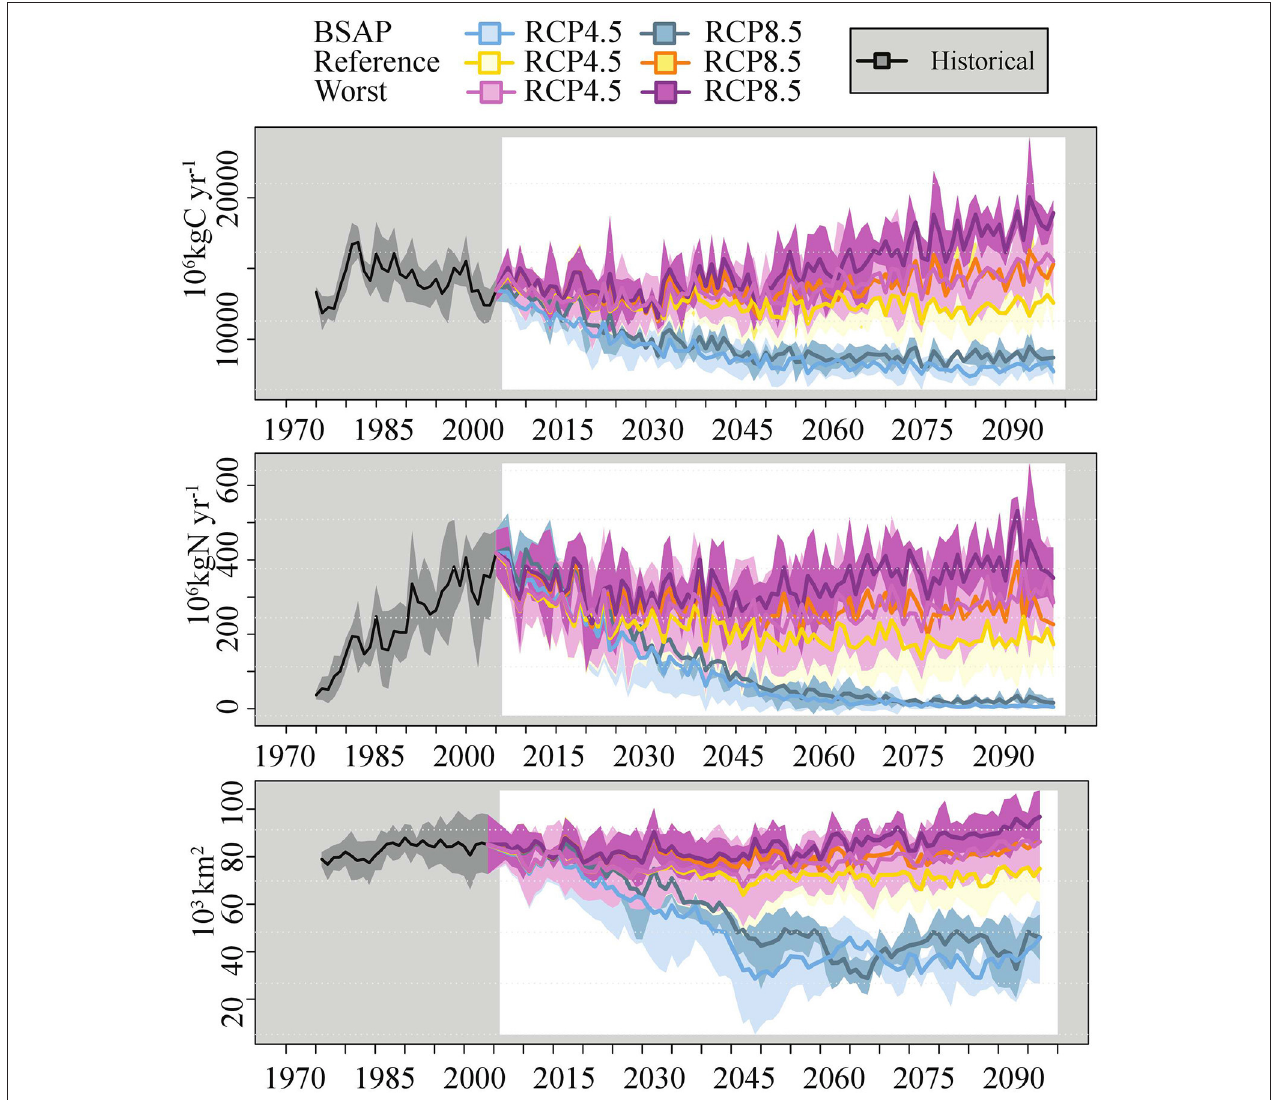
FIGURE 9 | Temporal evolution of ensemble mean volume averaged primary production (in 10 6 kg C year − 1 , upper panel) and nitrogen fixation (in 10 6 kg N year − 1 , middle panel), and hypoxic area (in 10 3 km 2 , lower panel) in the entire Baltic Sea during 1975–2098 and their standard deviations (ensemble spread) among ensemble members. For all combinations of the two greenhouse gas concentration scenarios (RCP 4.5 and 8.5) and the three nutrient load scenarios (BSAP, Reference and Worst Case) the ensemble mean and spread were calculated from four regionalized global climate